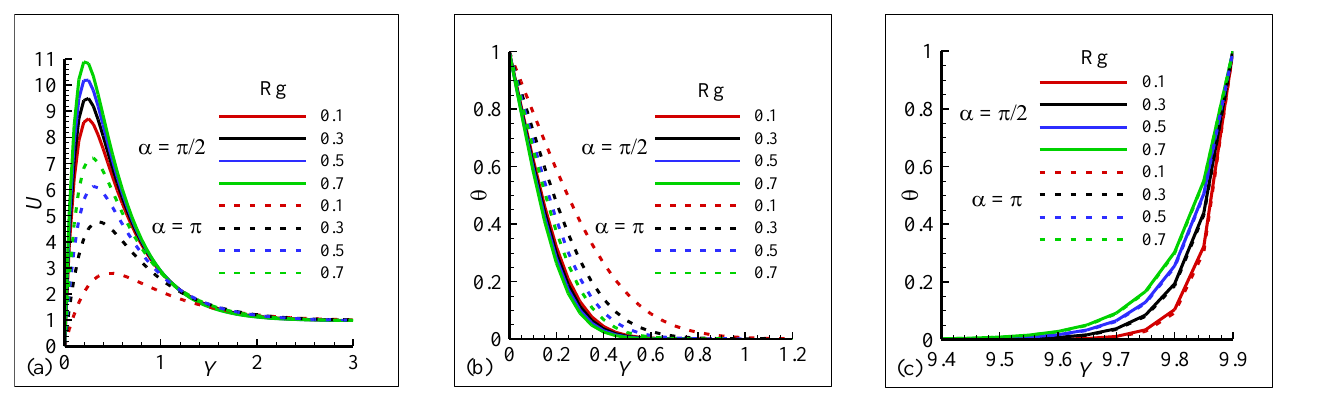
and π positions with four 2